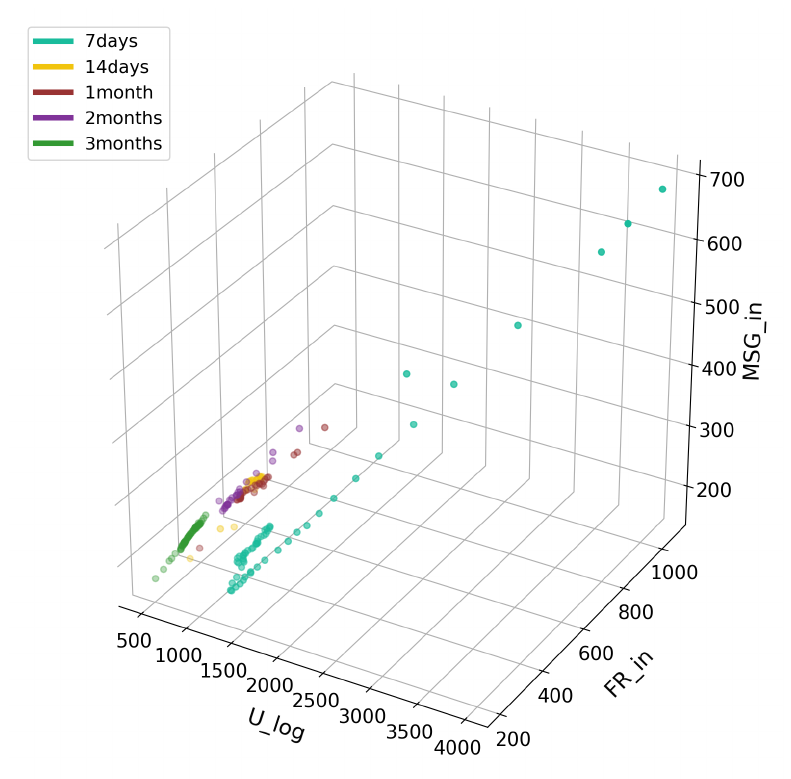
Figure 9. Dependence of objects in classes from U_log, FR_in and MSG_in variables.